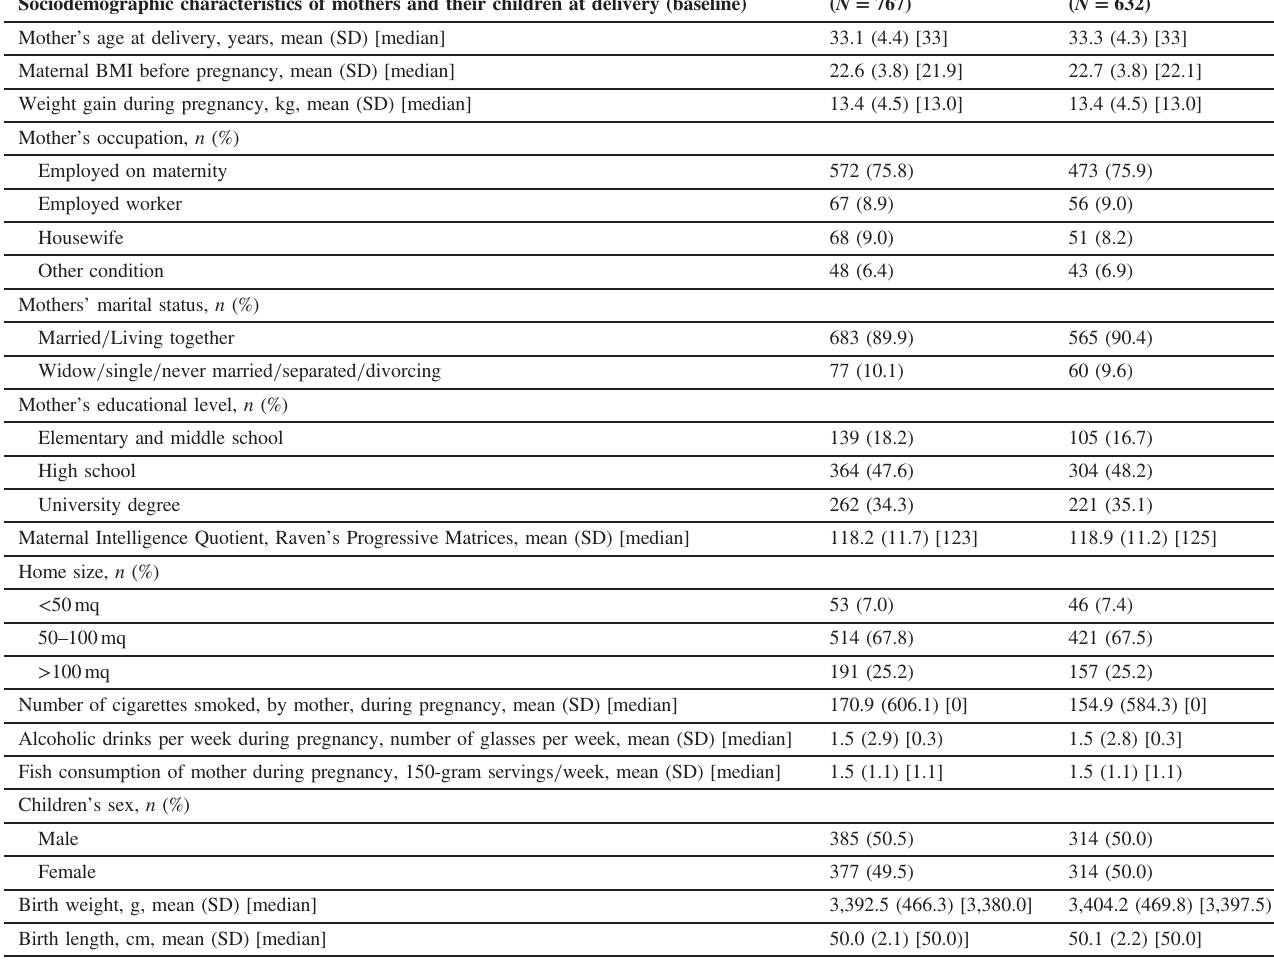
Table 1. Descriptive statistics at delivery Sociodemographic characteristics of mothers and their children at delivery